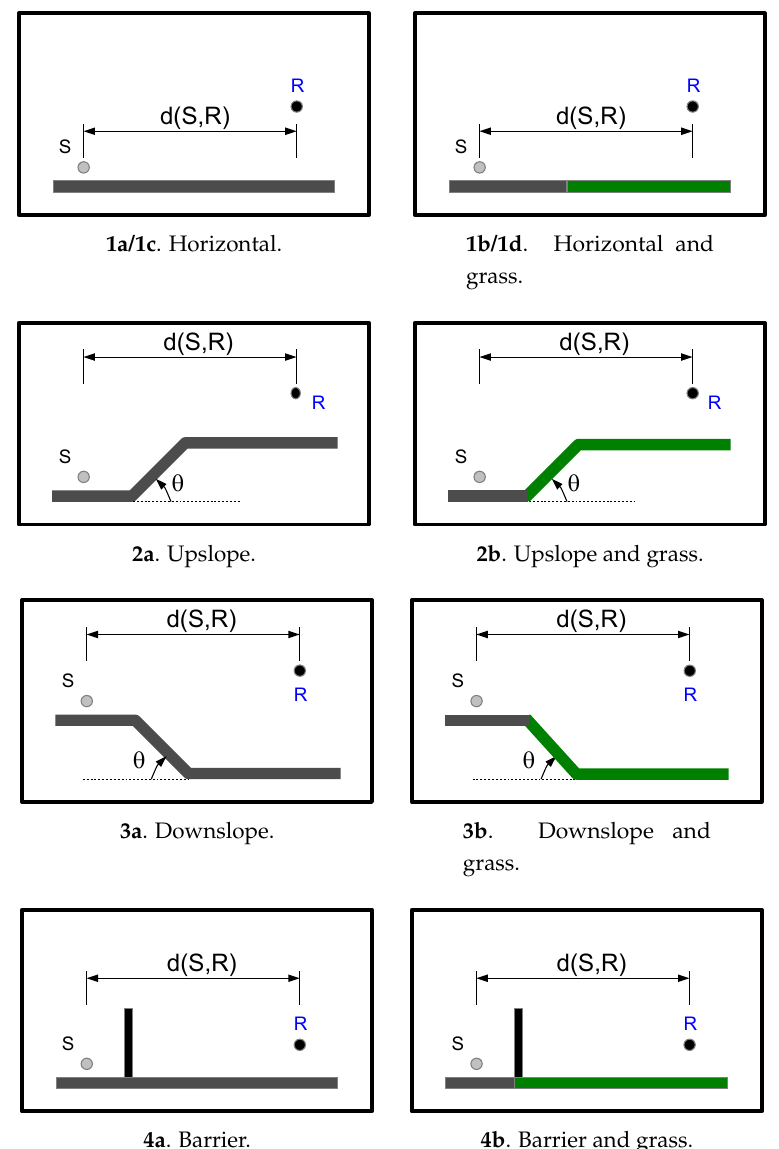
Figure 2. Road geometries (see Table 1 for more details): S is the sound source (road traffic) and R the observation point. For each road configuration, the road pavement may be a dense or a porous asphalt. Note that cases ( 1a/1c ) and ( 1b/1d ) are the reference standardized configurations